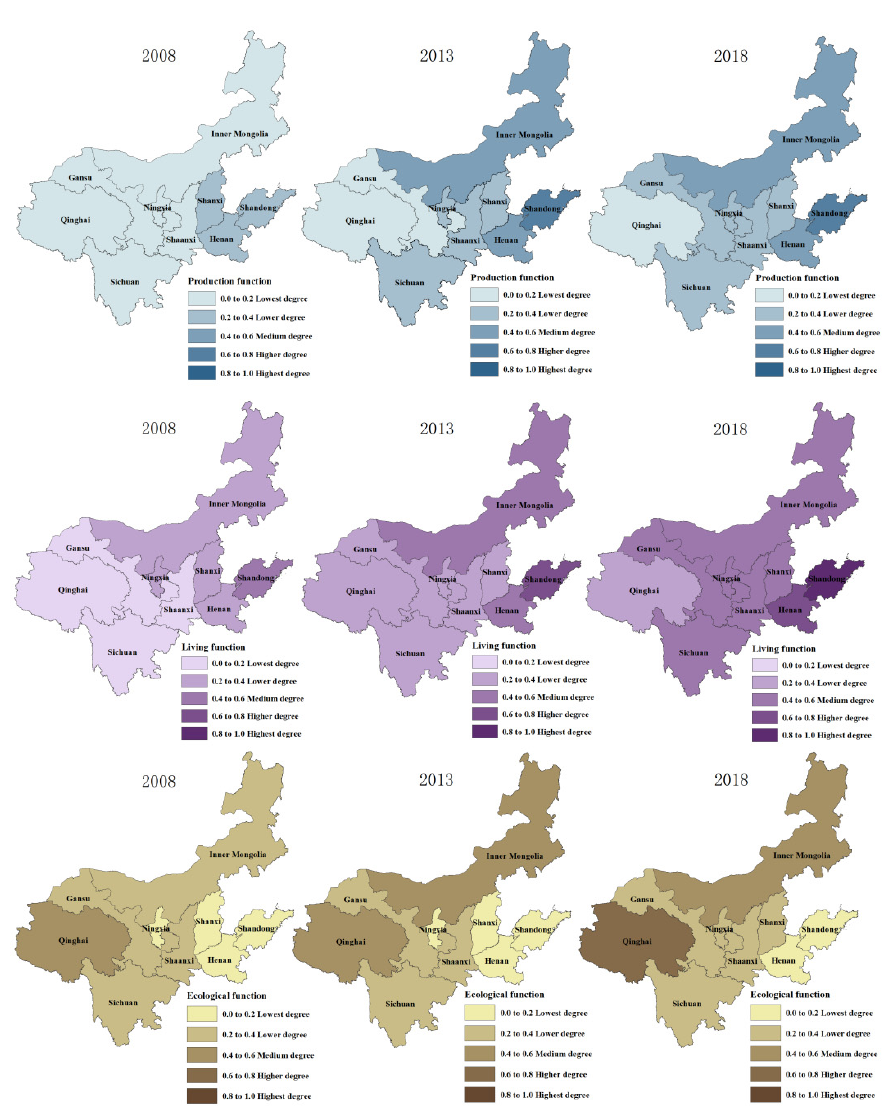
Figure 3. Spatial differentiation of “production-living-ecological” function in the Yellow River Basin.